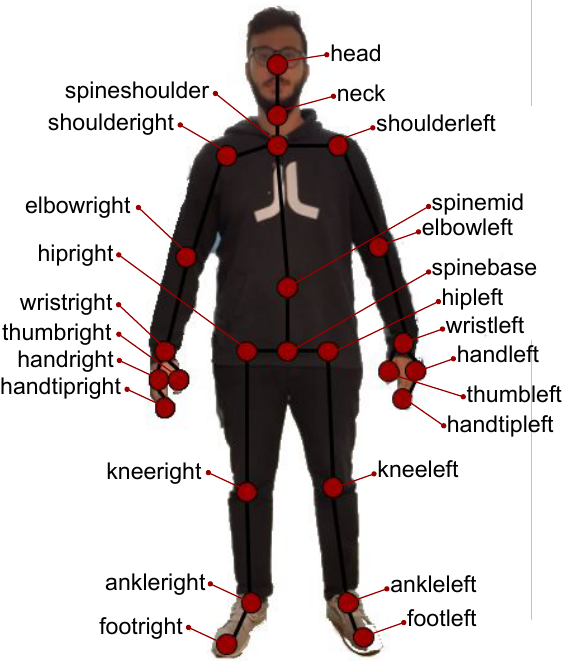
Figure 1. An extracted human skeleton. Red circles denote the positions on the human body of the 3D joints that are extracted using the Kinect